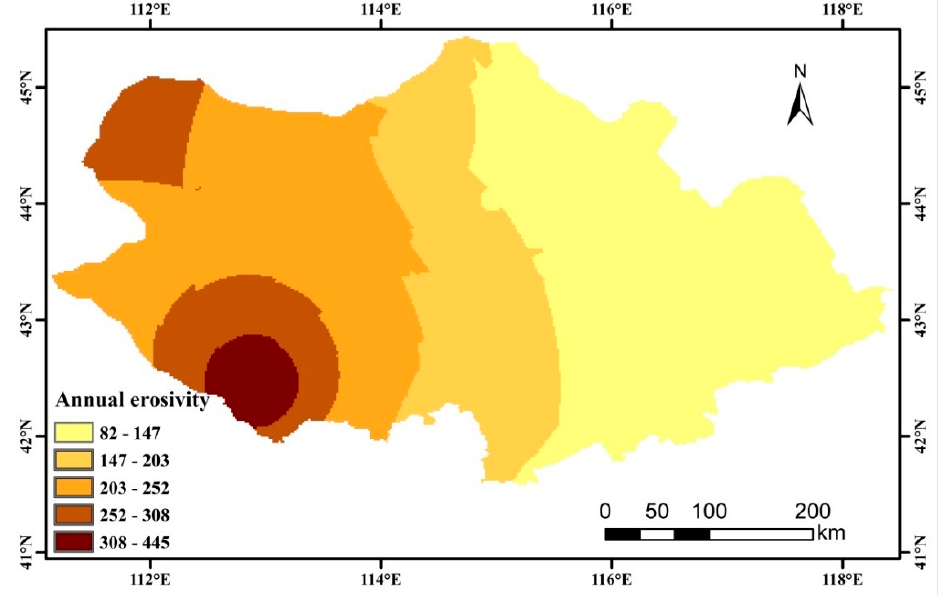
Figure 2. The 36-year average annual C-factor value distribution characteristics.